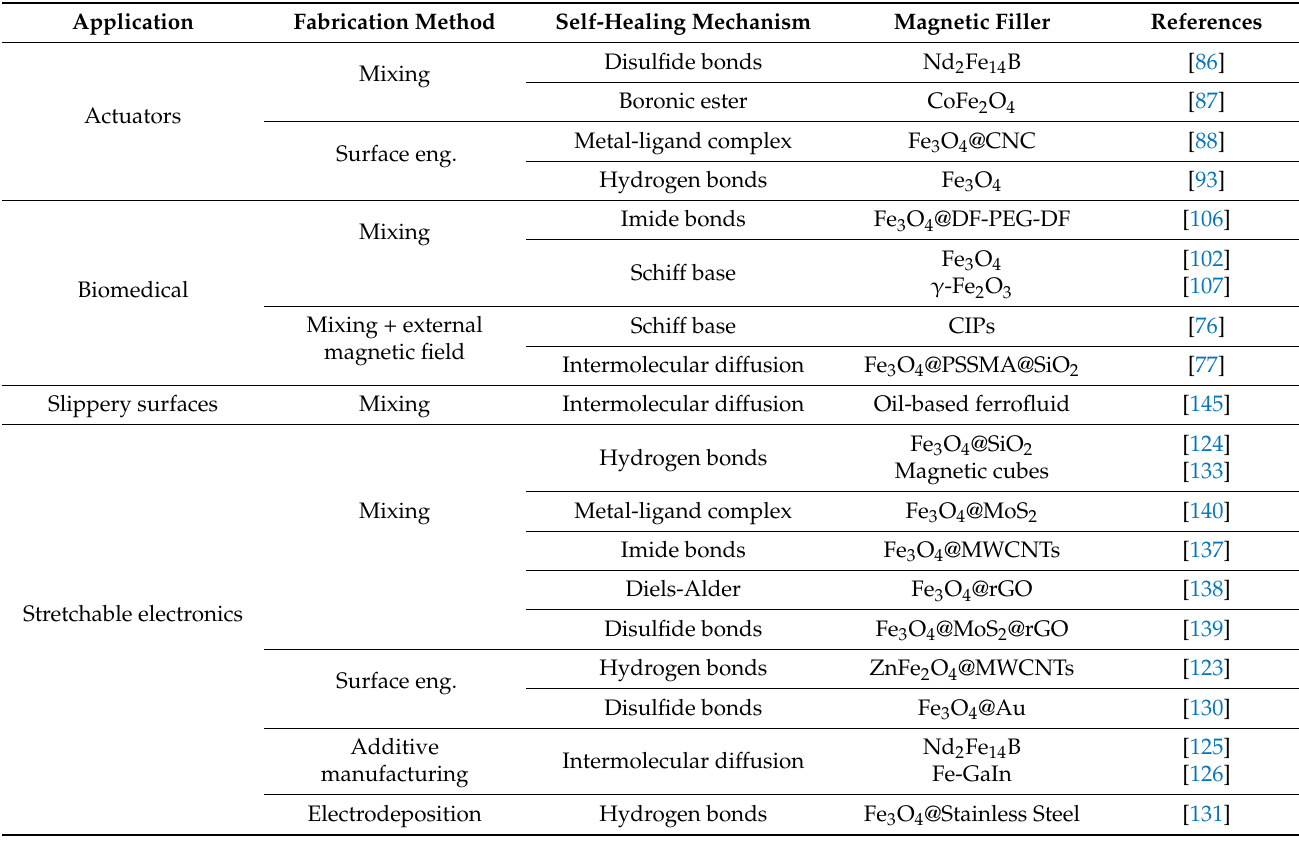
Table 3. The different self-healing mechanisms, magnetic fillers and fabrication methods reported for the evaluated magnetic self-healing application